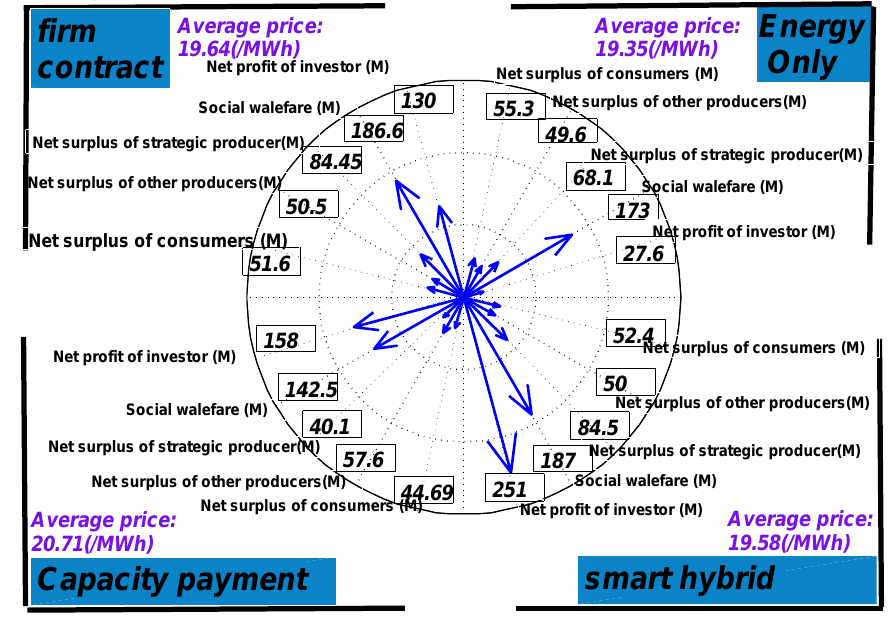
Figure 7. Parameters of energy generation expansion